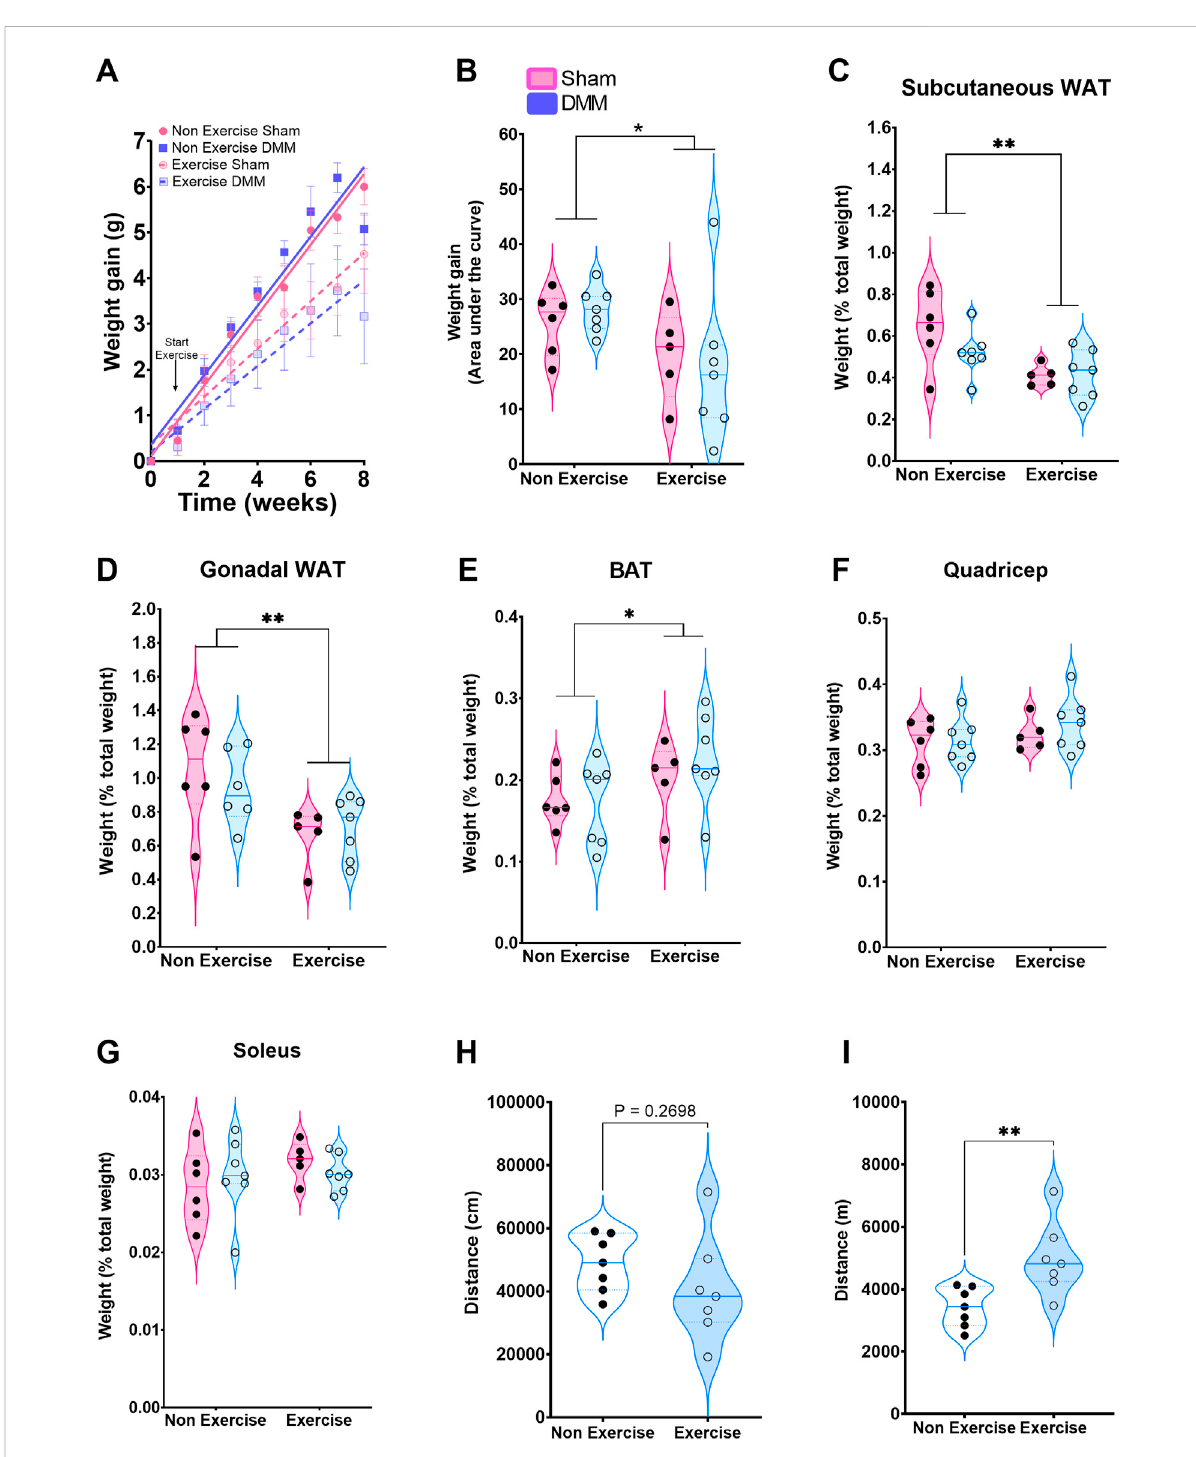
FIGURE 1 Overall effect of the exercise protocol on weight expressed as weight gain mean ± SEM (A) and area under the curve (B) . Subcutaneous (C) , gonadal (D) and brown (E) adipose tissue weight expressed as a percentage of total weight. Quadricep (F) and soleus (G) muscle weight as a percentage of total body weight. (H) Overnight distance travelled in DMM mice. (I) Calculated weekly distance based on overnight plus forced exercised distance. Arrow in (A) indicates start of exercise protocol. Weight gain was analyzed by mixed-effects model with time, surgery and exercise as factors. Time and exercise were signi fi cant (p < 0.0001). AuC, fat pad and muscle weight were analyzed with a 2-way ANOVA with Bonferroni correction. Movement in DMM groups was analyzed by Standard student t-test. *p < 0.05, **p <